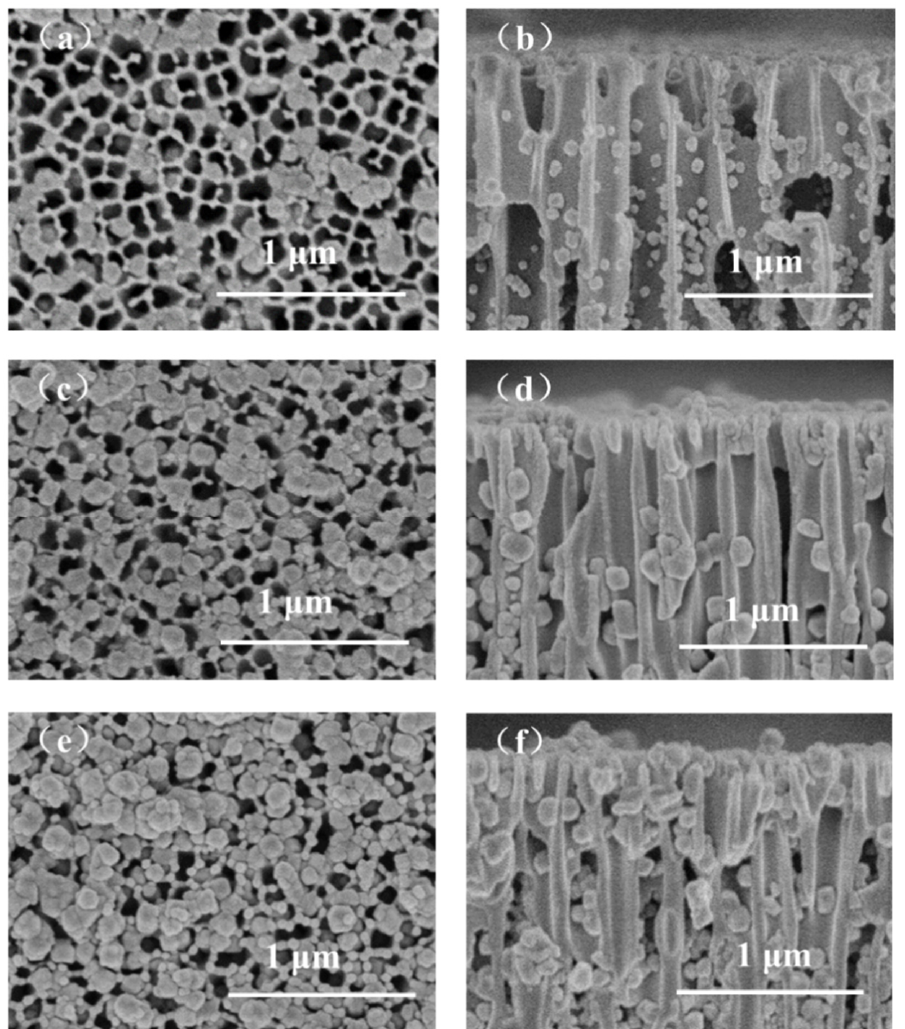
Figure 6. SEM images of ZIF-8/AAO membranes prepared with different deposition times, in which the left images are membrane surfaces and the right images are membrane cross-sections: ( a , b ) 20 min, ( c , d ) 40 min, ( e , f ) 60 min (constant voltage: 1 V, molar ratio of zinc ion to 2-methylimidazole: 1:75).